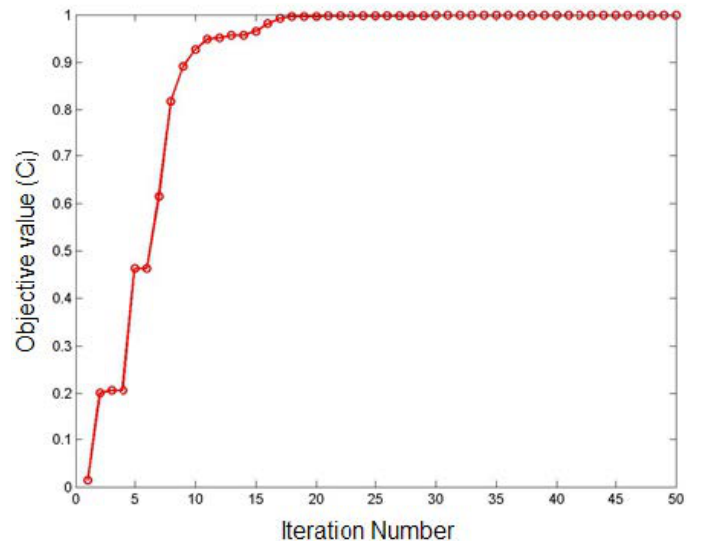
Table 8. Optimal values obtained through artificial bee colony algorithm.